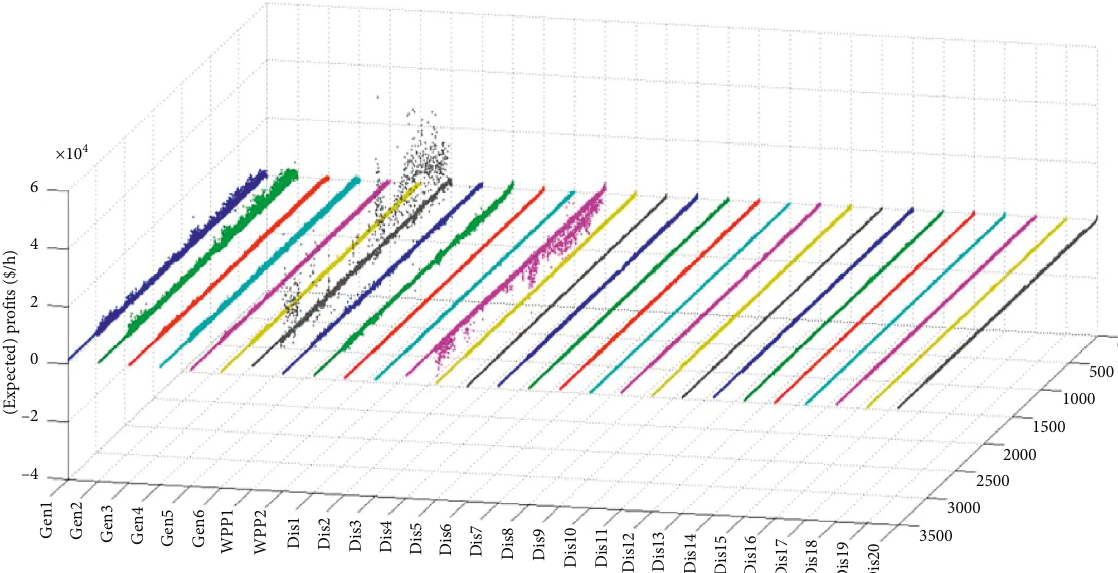
Figure 3: Dynamic adjusting process of (expected) profit of every agent in the GDCAC-based approach.